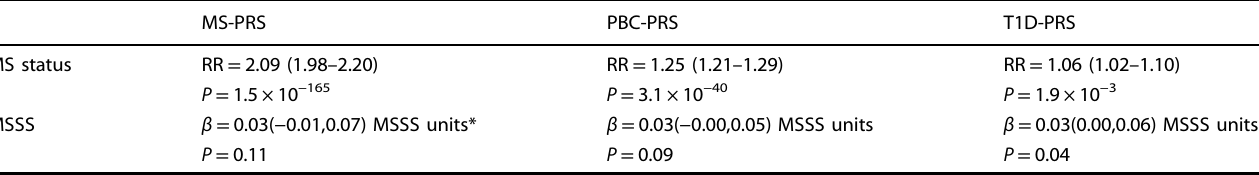
Table 2. Replication of primary biliary cirrhosis (PBC) and type 1 diabetes (T1D) polygenic risk score (PRS) prediction of multiple sclerosis (MS) in an independent Swedish cohort and results for the association of those PRSs and MS-PRS with the multiple sclerosis severity score (MSSS) after correcting for duration of